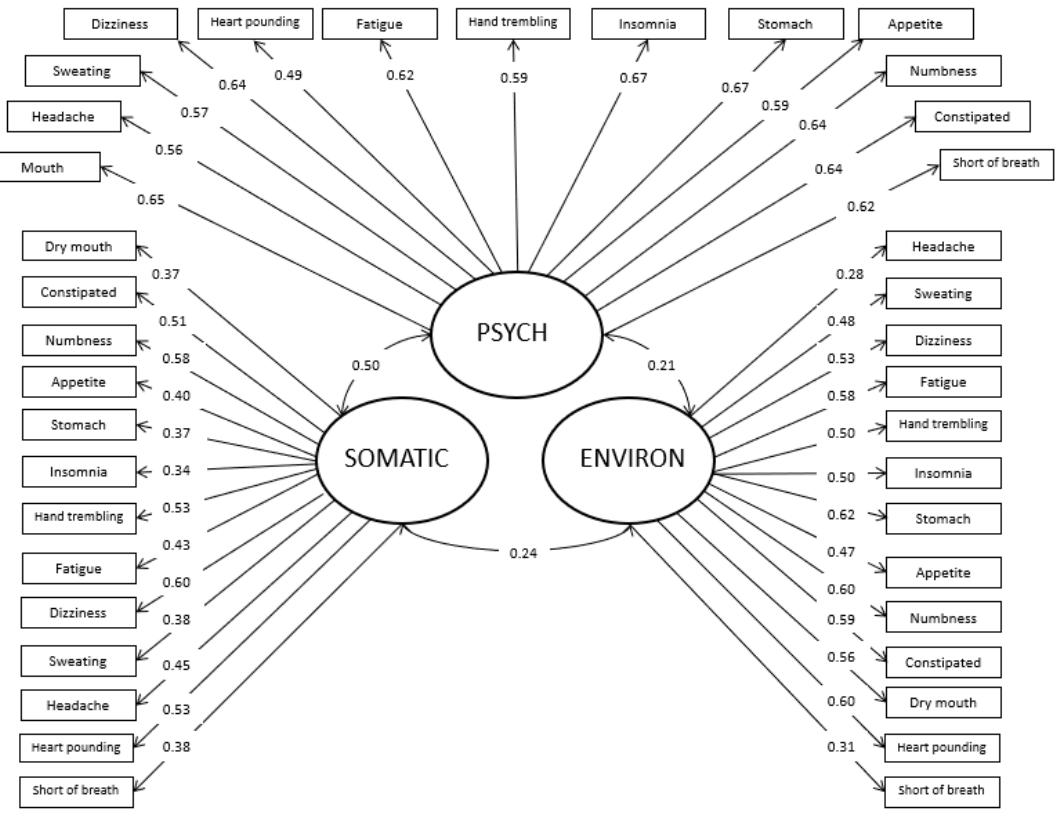
Figure 1. Confirmatory Factor Analysis model of Symptom Interpretation Questionnaire for parent report (SIQ-PR) with factor loadings.